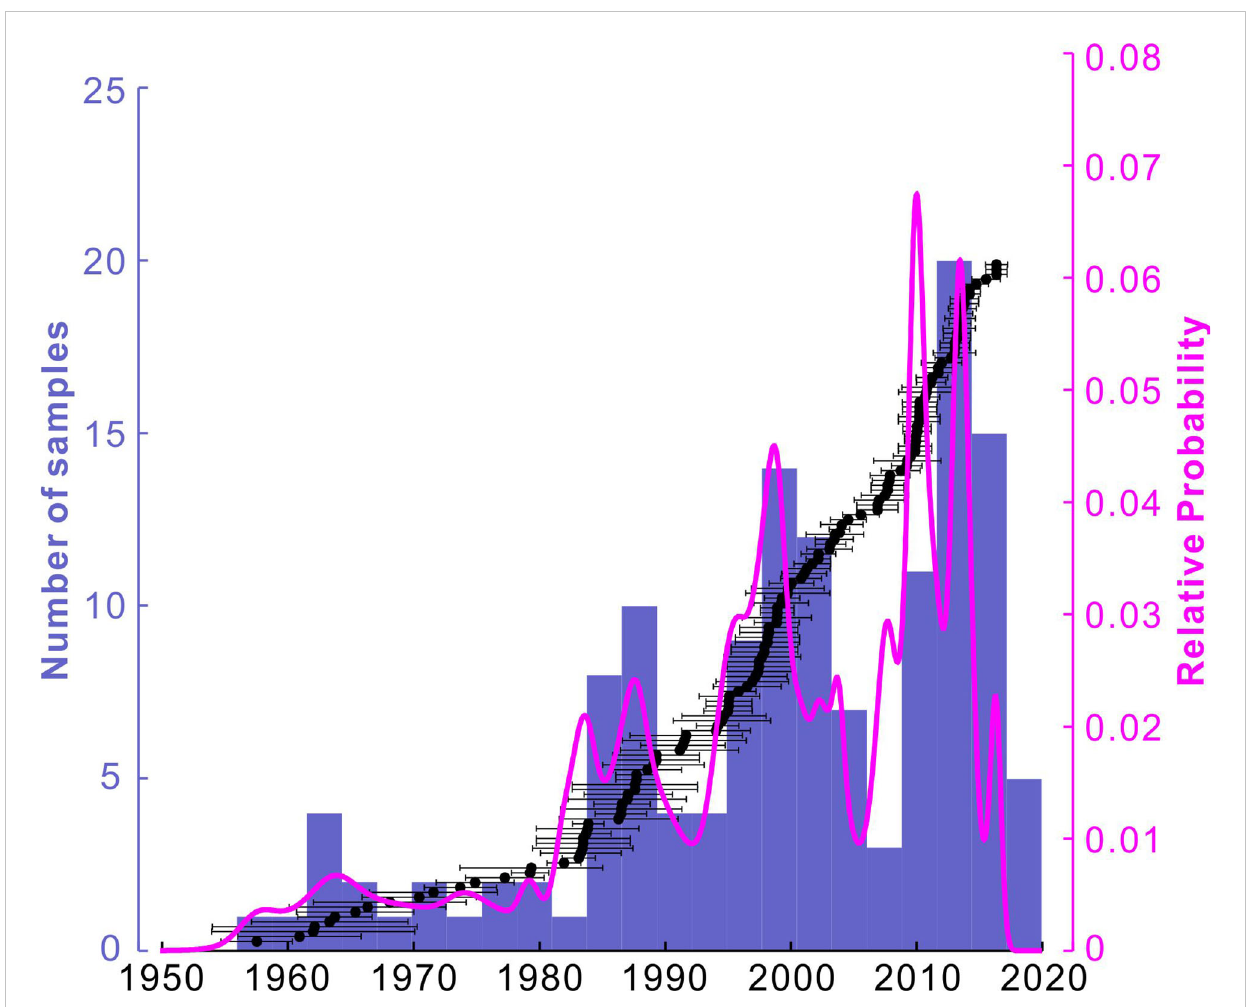
FIGURE 6 Histogram and relative probability of U-Th ages of sur fi cial dead Acropora corals. Individual U-Th ages ± 2 s errors are shown as black points with error bars. Raw data can be found in Supplementary Table